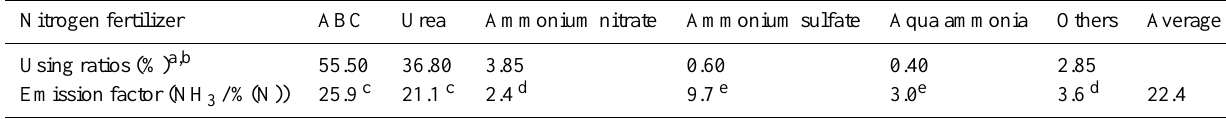
Table 2. Ratios of nitrogen fertilizer application and the emission factors. Nitrogen fertilizer ABC Urea Ammonium nitrate Ammonium sulfate Aqua ammonia Others Using ratios (%) a,b 55.50 Emission factor (NH 3